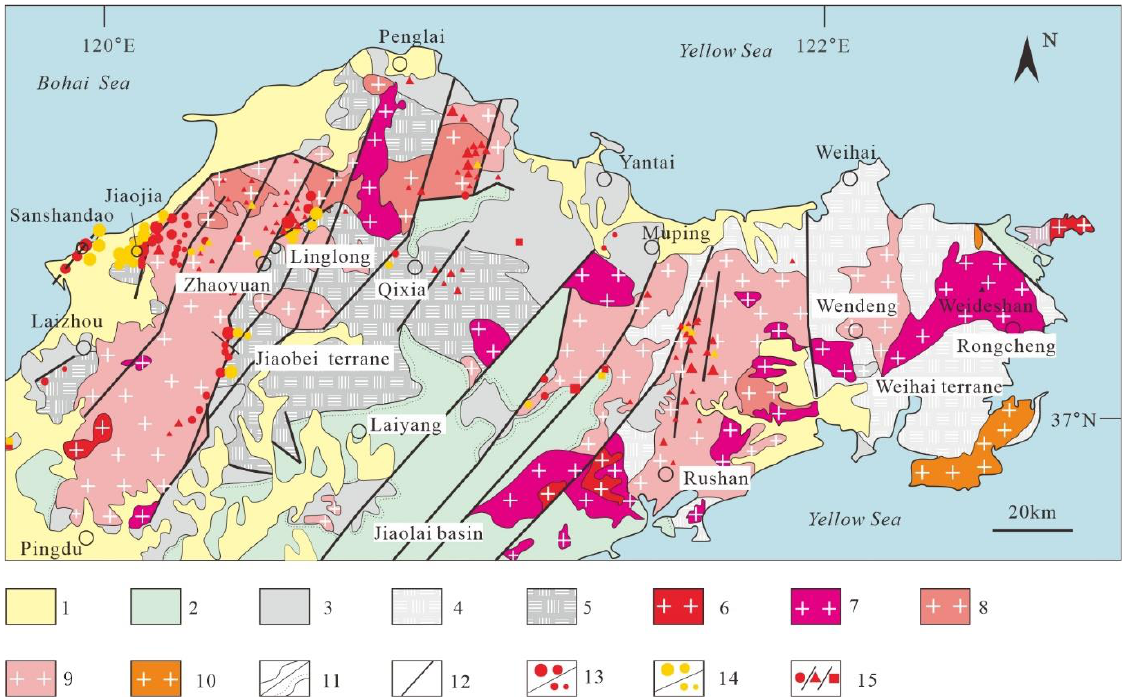
Figure 1. Map showing the regional geology and gold deposit distribution in the Jiaodong Peninsula. 1 — Quaternary; 2 — Cretaceous; 3 — Paleoproterozoic and Neoproterozoic; 4 — Neoproterozoic bearing eclogite granitic gneiss; 5 — Archean granite-greenstone belt; 6 — Cretaceous Laoshan granite; 7 — Cretaceous Weideshan granite; 8 — Cretaceous Guojialing granite; 9 — Jurassic Linglong granite; 10 — Triassic granitoid; 11 — Geological boundary of conformity/unconformity; 12 — Fault; 13 — Shallow gold deposits (very large and large/medium-scale and small); 14 — Deep-seated gold deposits (very large and large/medium-scale and small); 15 — Gold deposit of altered-rock-type/quartz-vein-type/altered-breccia- type.